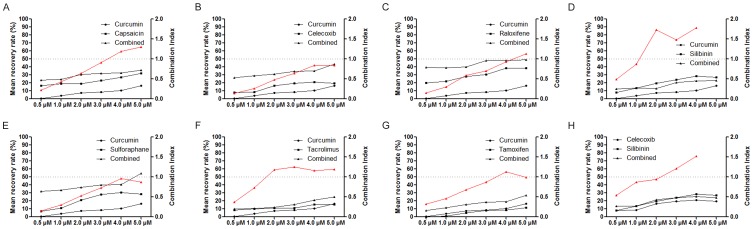
Evaluation of a protective effect of 2-drug combinations (in the concentration range from 0.5 to 5.0 µM) against H2O2-induced myocardial apoptosis in ventricular cardiomyocytes of neonatal rats.A–G. Combination effects of curcumin with one of the other drugs at a dose ratio of 1∶1; H. The combination effect of celecoxib and silibinin at a dose ratio of 1∶1. The red line with triangles shows the results of calculation of the combination index. A combination index of less than 1.0 indicates potential synergism of the 2 drugs in question.